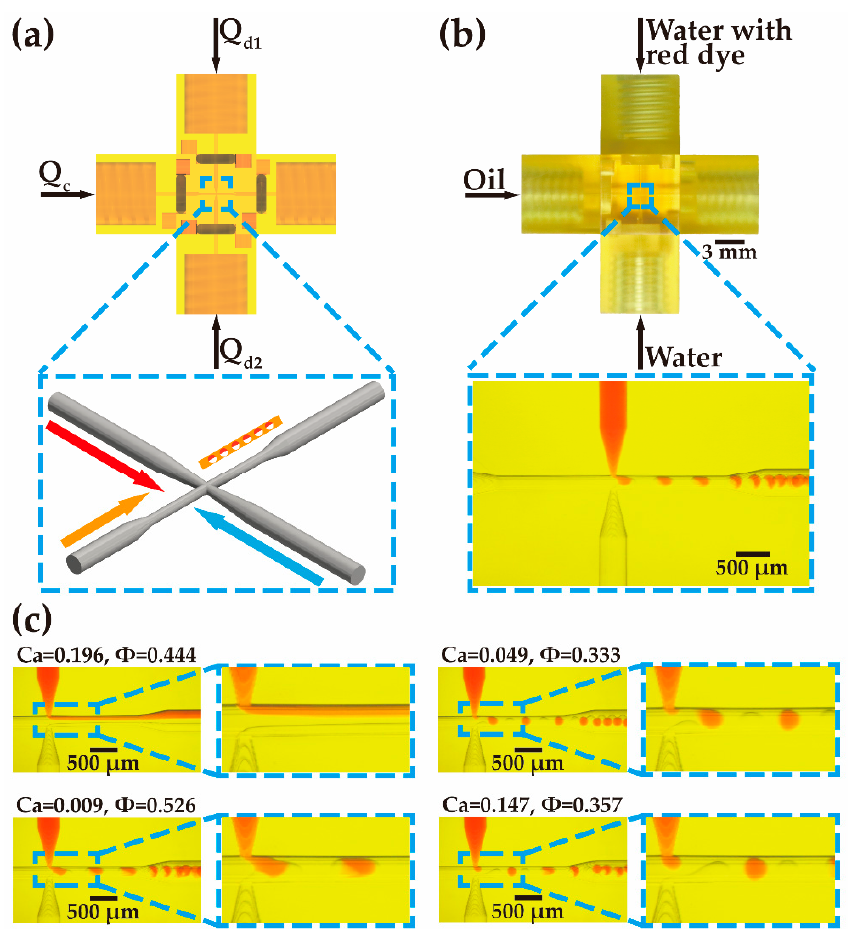
Figure 5. Schematic illustration of alternating-droplet and merged-droplet generation. ( a ) Schematic and ( b ) the printed sample of assembled passive alternating droplet- and merged droplet-generation devices, respectively. ( c ) Optical micrographs of different flow regimes for different values of Ca and Φ .